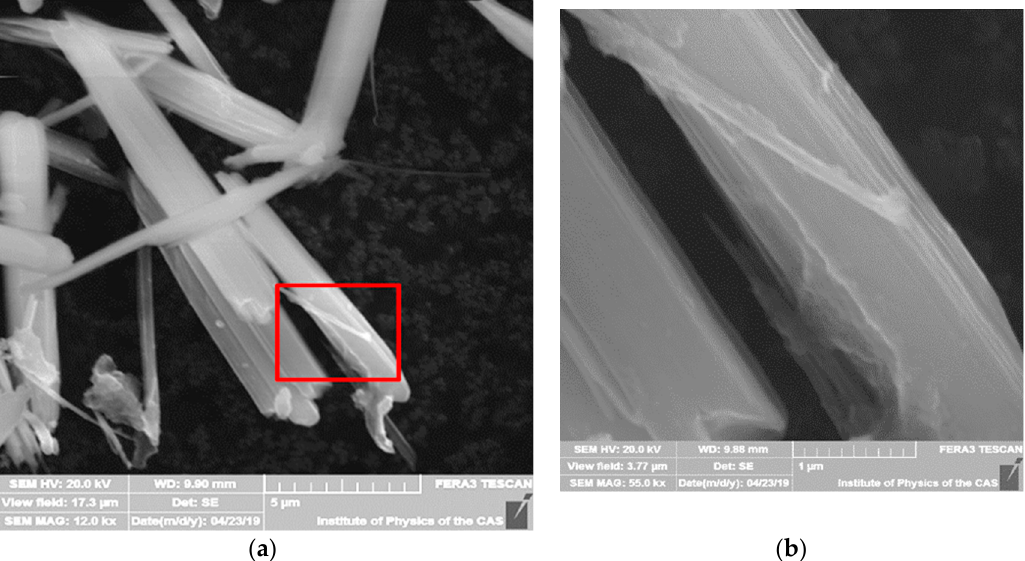
Figure 3. SEM images of the Cu/TiO 2 _500 sample, ( a ) Cu/TiO 2 _500 at low magnification ( b ) Cu/TiO 2 _500 detail from red boxed area in Figure 3a.